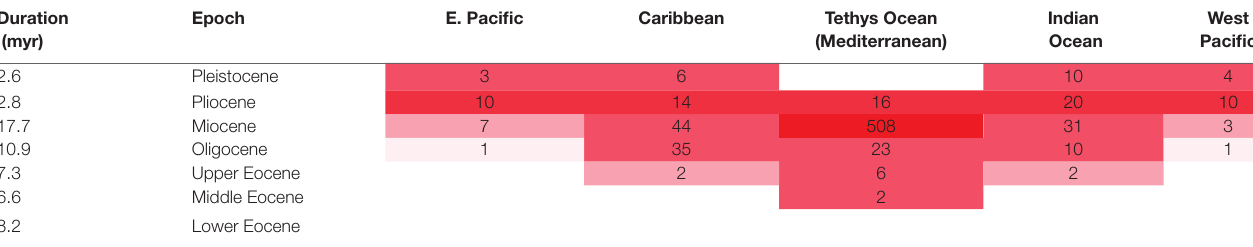
TABLE 2 | Species occurrences of the 397 fossil species in Ali’s (1983) compilation of the genus Clypeaster by time and geographic region. Duration (myr)